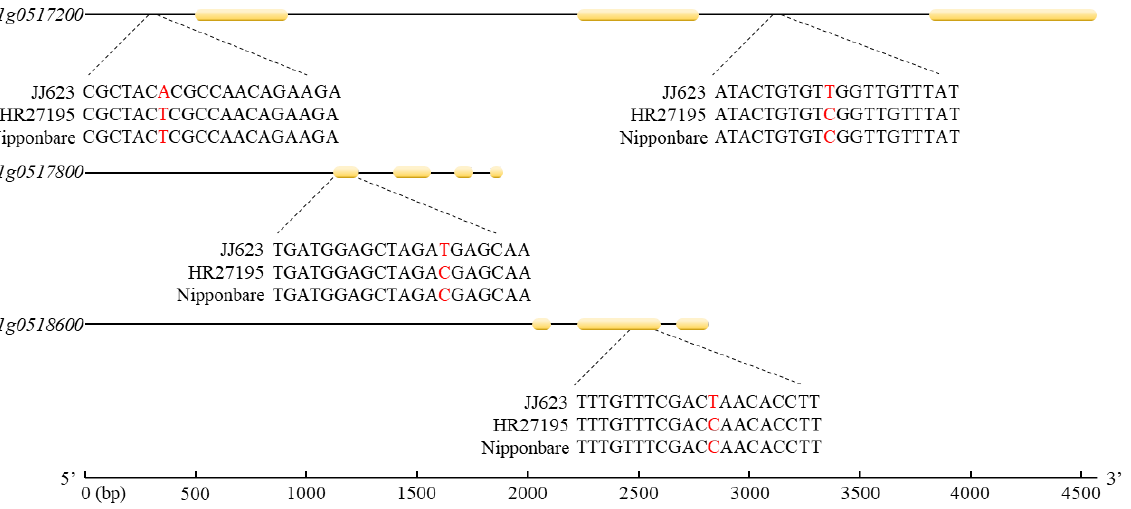
Figure 4. Sequence difference analysis of Os11g0517200 , Os11g0517800 , and Os11g0518600 of JJ623 and HR27195 by SNP. Among the candidate genes related to BB resistance detected by qBRR11 , SNPs were identified from Os11g0517200 , Os11g0517800 , and Os11g0518600 . In Os11g0517200 .